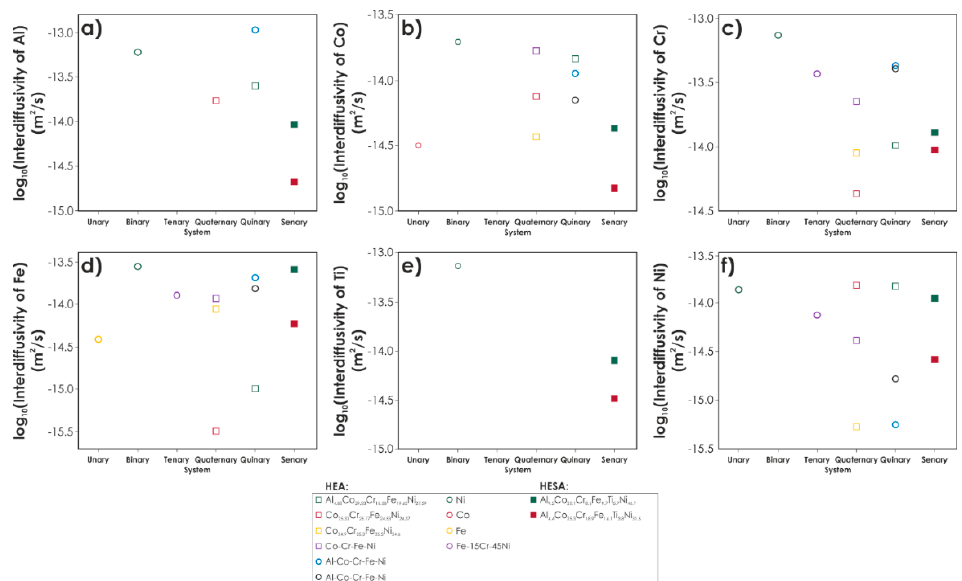
Figure 17. Comparisons of the tracer diffusivities for the Al-Co-Cr-Fe-Ni-Ti system with the literature data in the other FCC alloys and pure metals (after [38]). Reprinted from Journal of Alloys and Compounds 791 (2019), On diffusion behaviors in face centered cubic phase of Al-Co-Cr-Fe-Ni-Ti high-entropy superalloys, 255–264, Copyright 2019, with permission from Elsevier.